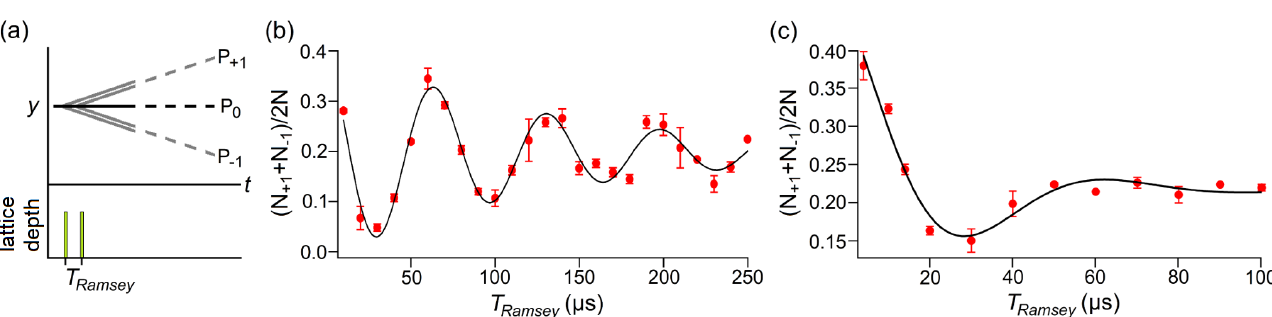
Figure 7. Characterization of DKC by coherence length measurements using Ramsey interferometry. ( a ) space-time diagram of a momentum-space Ramsey interferometer composed of two Kapitza-Dirac pulses. Decaying oscillations of population amplitude, with ( b ) and without ( c ) delta-kick collimation. The fit function, f ( t ) = Ae − t / τ sin ( 4 ω rec t + φ ) + f 0 , returns Ramsey coherence times of τ = 129 ± 18 µ s and 23 ± 3 µ s,